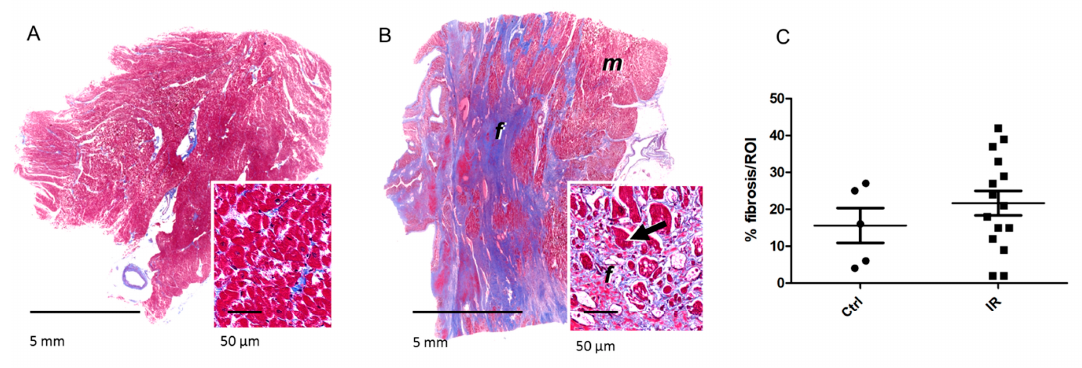
Figure 6. The detection of fibrosis in the heart samples. The sections were stained with Mason’s Trichrome for visualization of connective tissue. The fibrotic area was shown in representative sections of the myocardium in control ( A ) and irradiated samples ( B ). Myocytes ( m ) are stained in red, fibrous connective tissue ( f ) in blue. The arrows indicate degenerating cardiomyocytes entrapped by fibrosis. The areas of fibrotic tissue within the myocardium were quantified and presented as percentage of region of interest (ROI) ( C ). The icons represent individual samples in control (Ctrl) and irradiated (IR) groups. The details are given in Table S6.